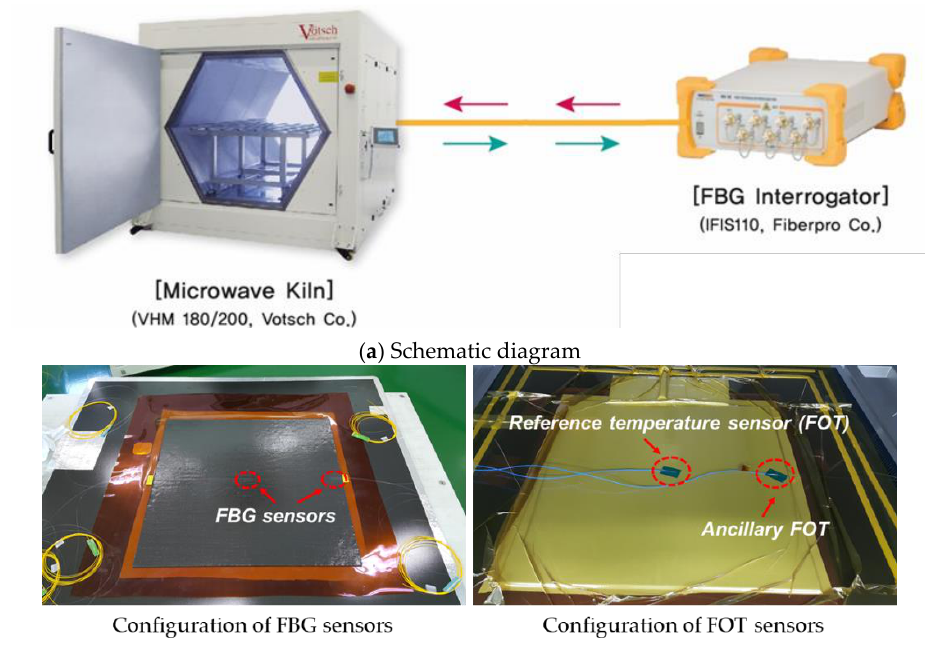
Figure 4. Typical curing cycle of the autoclave method.